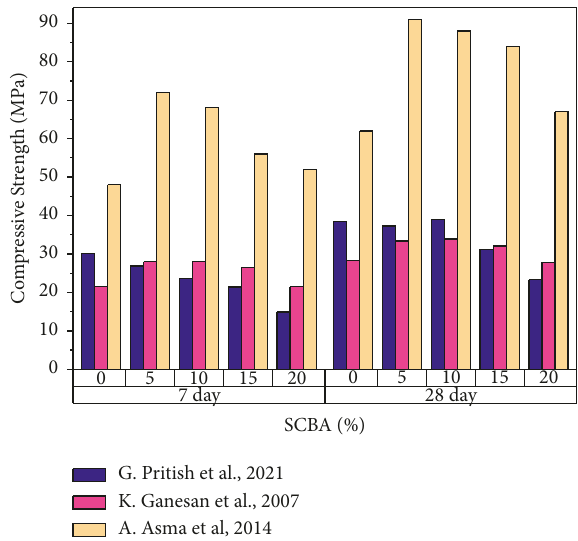
Figure 24: Compressive strength of SCBA-based